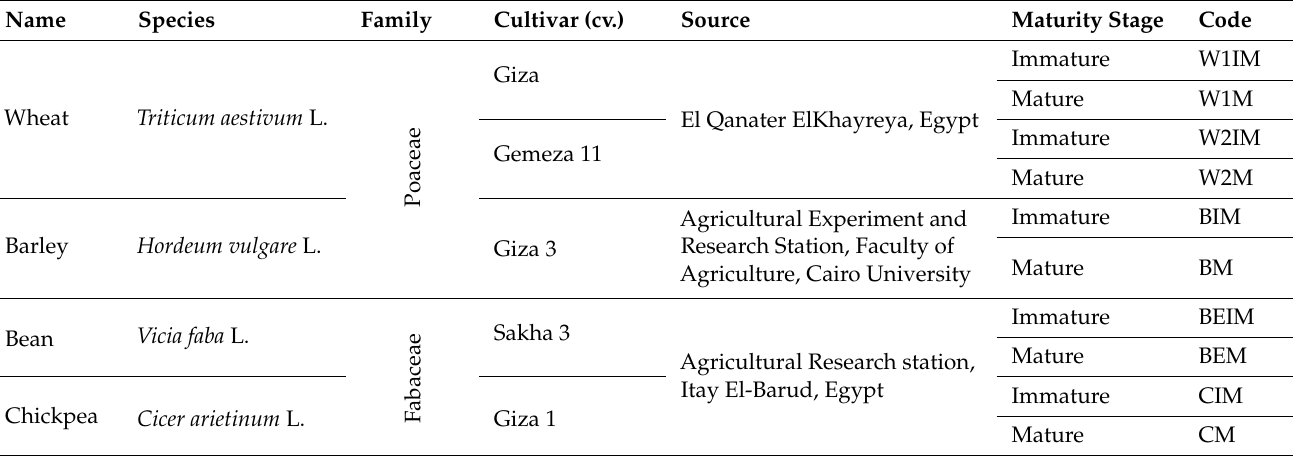
Table 1. Species, source, maturity stage and codes of the different seeds used in this